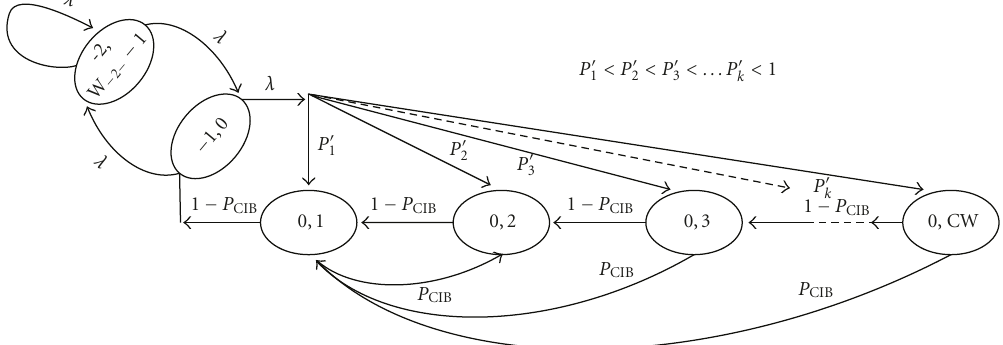
Figure 6: Markov Chain for IB Method.